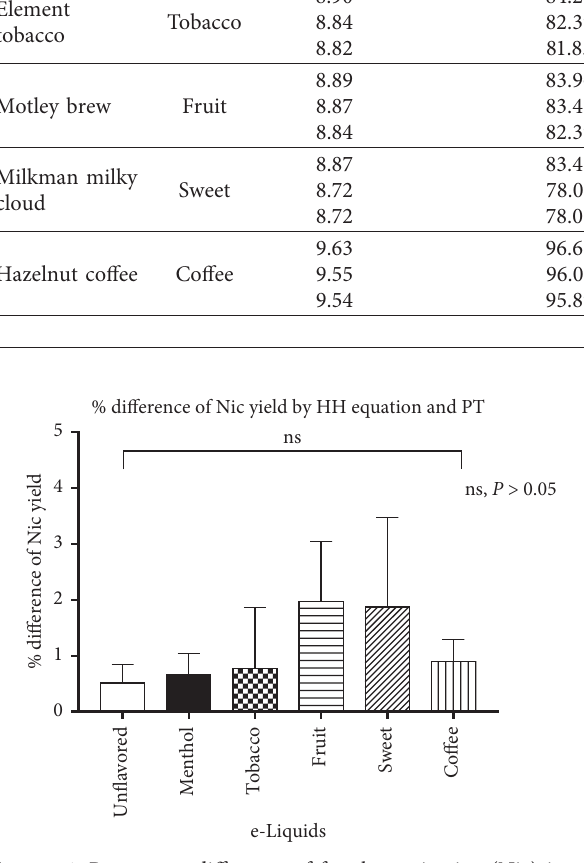
Figure 4: Percentage difference of free base nicotine (Nic) in e- liquids by HH equation vs. potentiometry (ns, P > 0 . 05; statistical analysis was carried out using GraphPad Prism